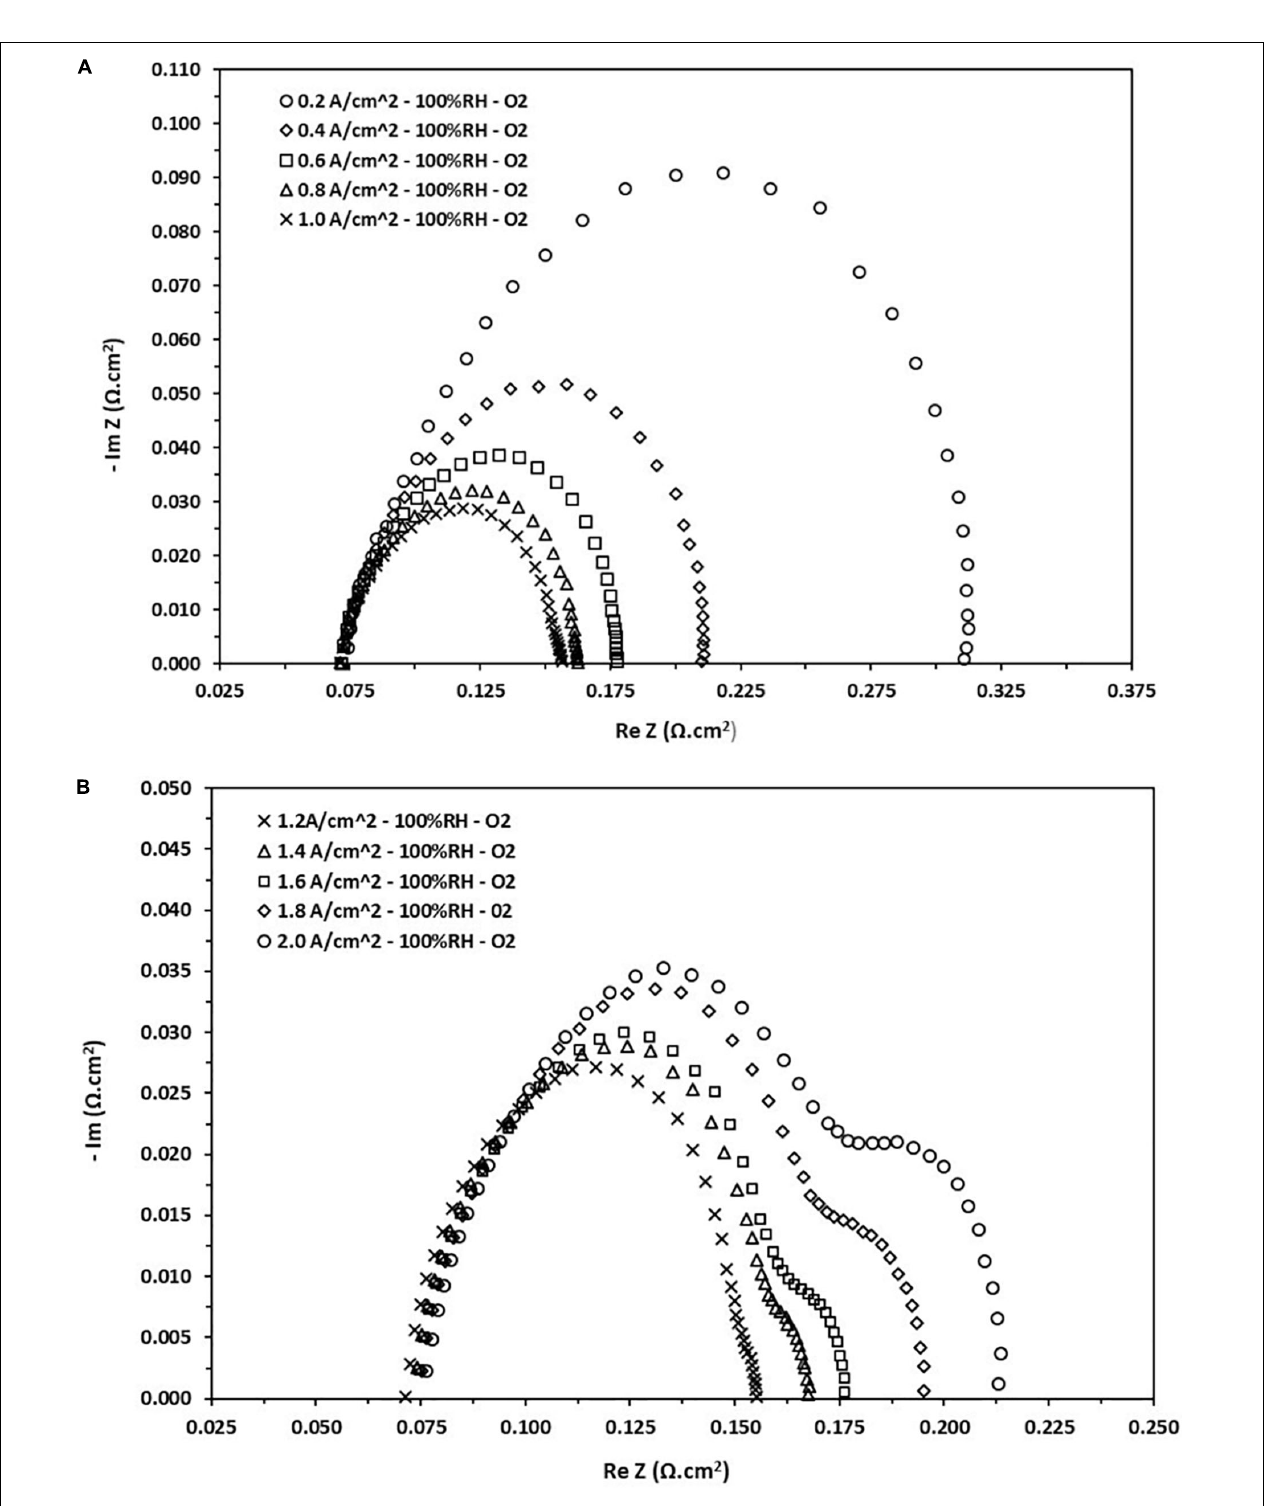
FIGURE 5 | Nyquist diagram obtained from the EIS test at different current loads at 100% RH. (A) Density current from 0.2 to 1.0 A/cm 2 . (B) Density current from 1.2 to 2.0 A/cm 2 .